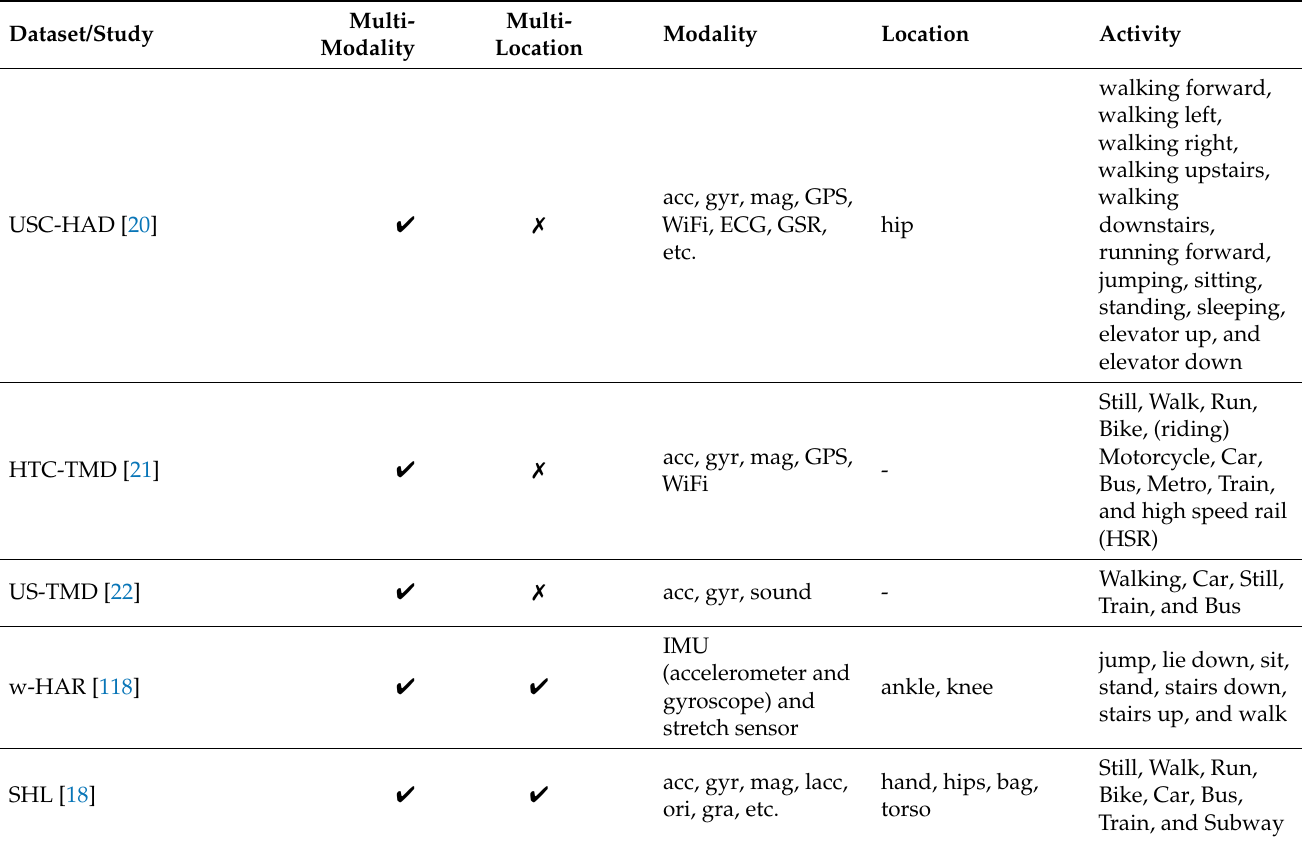
Table 4. Details of the datasets used to evaluate the impact of incorporating the derived surrogate model of the data acqui- sition step into activity recognition models. Illustrated details include the availability of multiple modalities in multiple locations simultaneously. Motion-based modalities, which are referred to with the following abbreviations: acc (accelerome- ter), gyr (gyroscope), mag (magnetometer), lac (linear accelerometer) gra (gravity) ori (orientation), and pre (pressure). In addition, GPS refers to global positioning system, GSR to galvanic skin response, and ECG to electrocardiogram. Dataset/Study